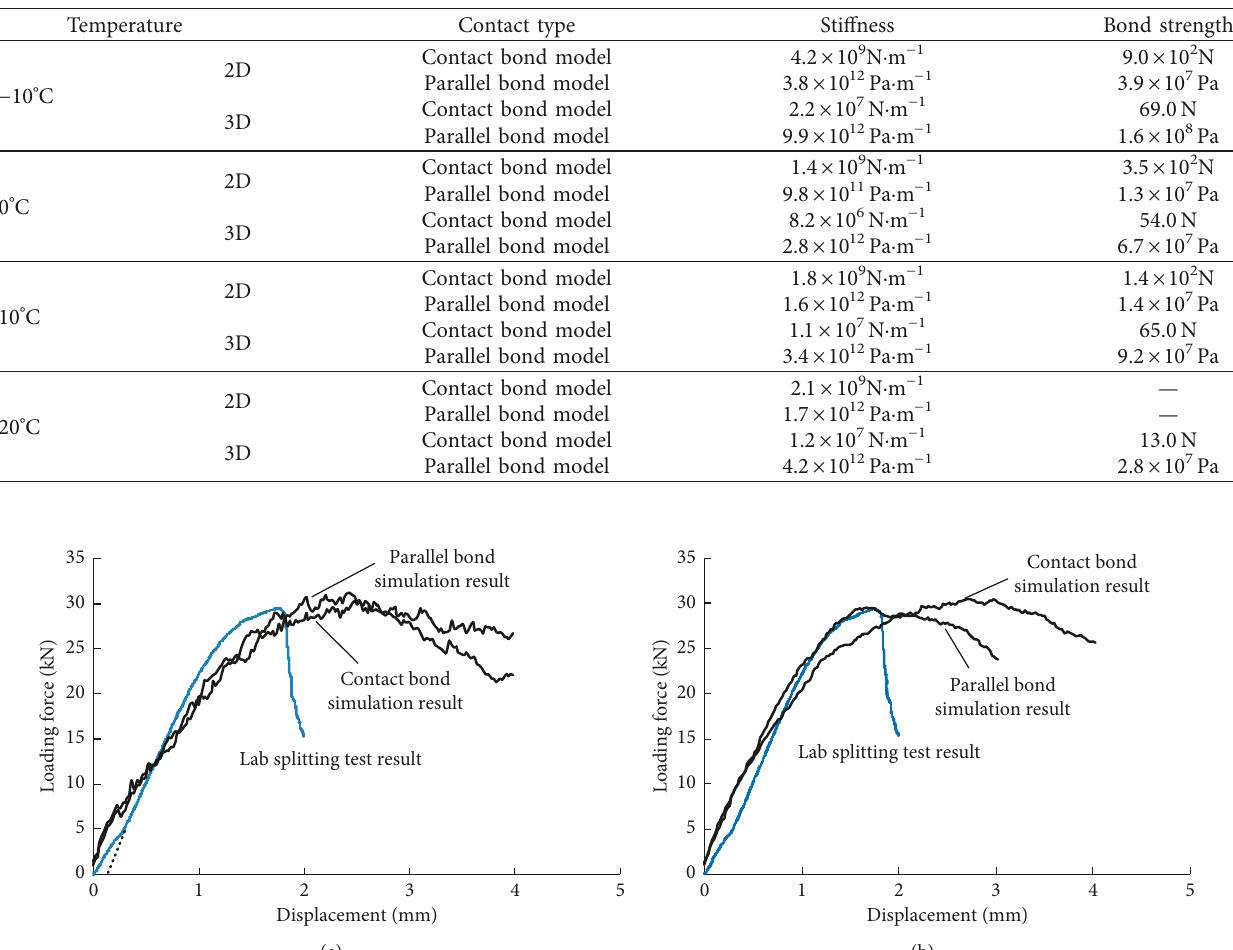
Table 3: Discrete bond model parameters of AC-13.